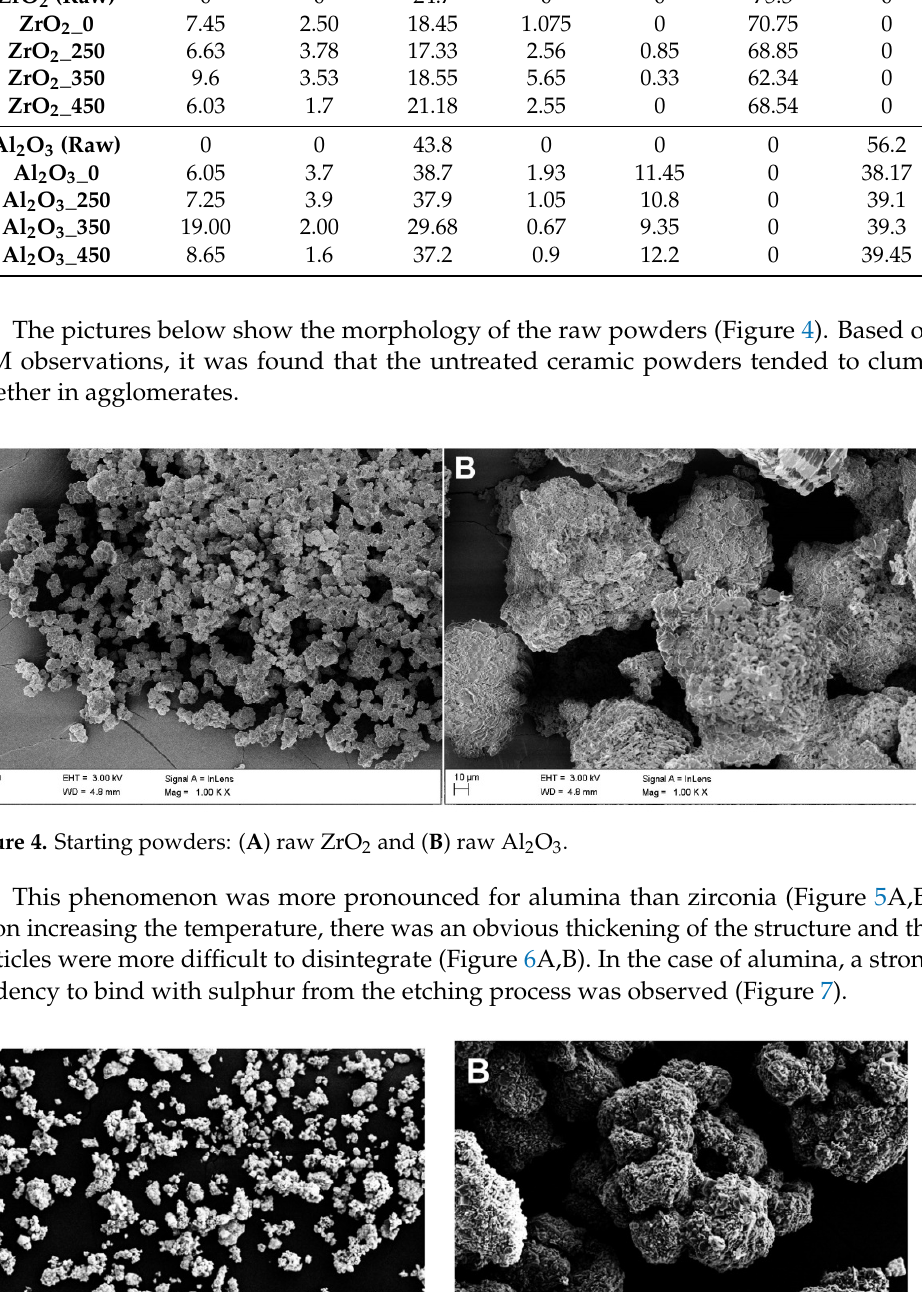
Figure 6. Morphology of the APTES-modified zirconia and alumina powders: ( A ) ZrO 2 _250 and ( B ) ZrO 2 _450. Figure 7. Sulphur contamination in modified alumina sample—Al 2 O 3 _450. The PSDs of the ZrO 2 and Al 2 O 3 modified powders are described in Figure 8 and Tables 3 and 4. These results are the mean of five measurements. The PSD measurements were made after the last modification process, i.e., calcination. Only two samples, ZrO2_0 and Al2O3_0, were not calcined to provide a comparison. The ZrO 2 powder had a larger PSD but smaller particles compared to the Al 2 O 3 powder (Figure 8).